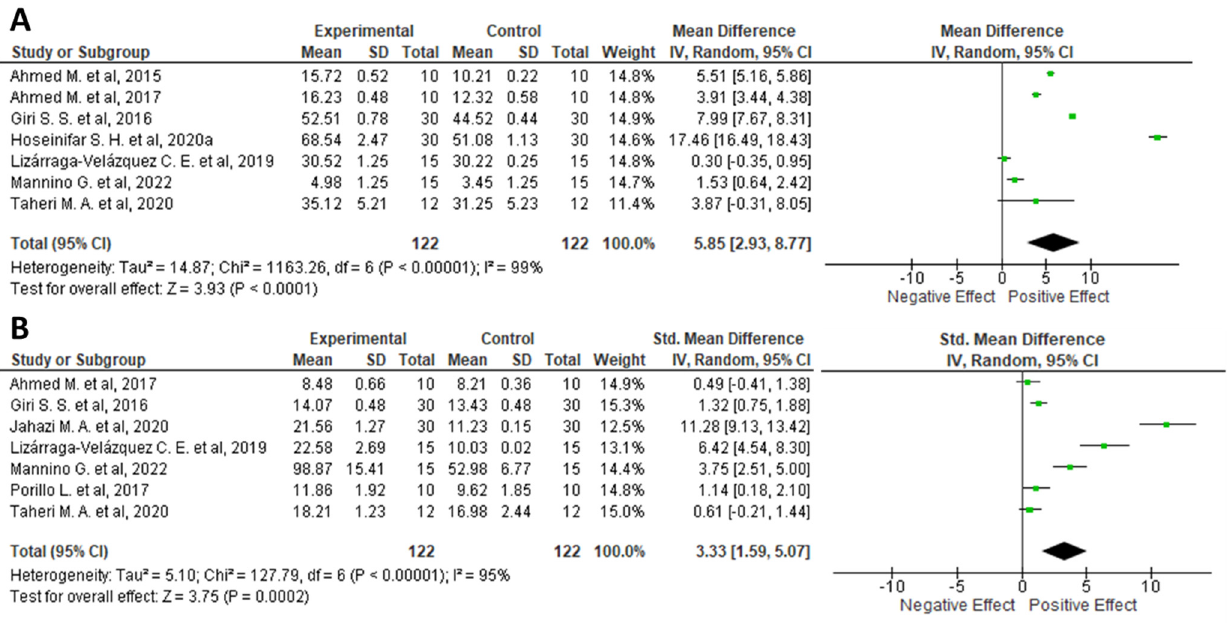
Figure 6. Forest plot representation of effects on Superoxide Dismutase (SOD) ( A ) and Catalase (CAT) ( B ) derived from supplementing fish diets with plant waste. Data were extracted from eight articles [20,34,44–49], and plotted according to mean difference. Each horizontal line in the graph represents an individual and specific study, with the experimental mean value displayed as a green box. For each study, if the horizontal line (95% CI) crosses the vertical line (absence of effect), no statistically significant differences can be observed between the experimental and control group. The black diamond at the bottom of the forest plot represents the average effect size calculated from the combination of the results from all selected studies. The output was generated via Review Manager (RevMan) [Computer program]. Version 5.4. The Cochrane Collaboration, 2020.